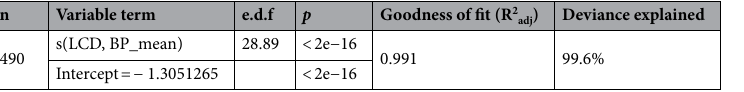
Table 6. Summary of the generalized additive model (GAM) analysis for modeling the genetic affinity (f3) between the modern Caucasians and ancient populations in relation to standardized values of least-cost distance (LCD) and mean time BP. n = sample size; s() = spline smooth function with interaction between the two variables; e.d.f. = estimated degrees of freedom; p = significance of terms.